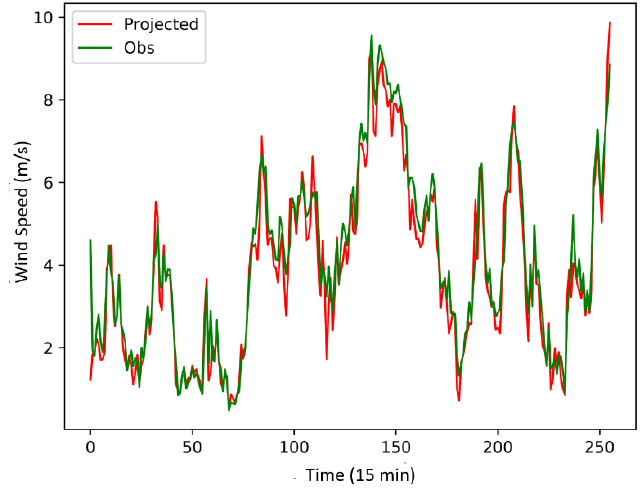
Figure 3. An example of time series projection of wind speed by the Bi ‐ LSTM model.